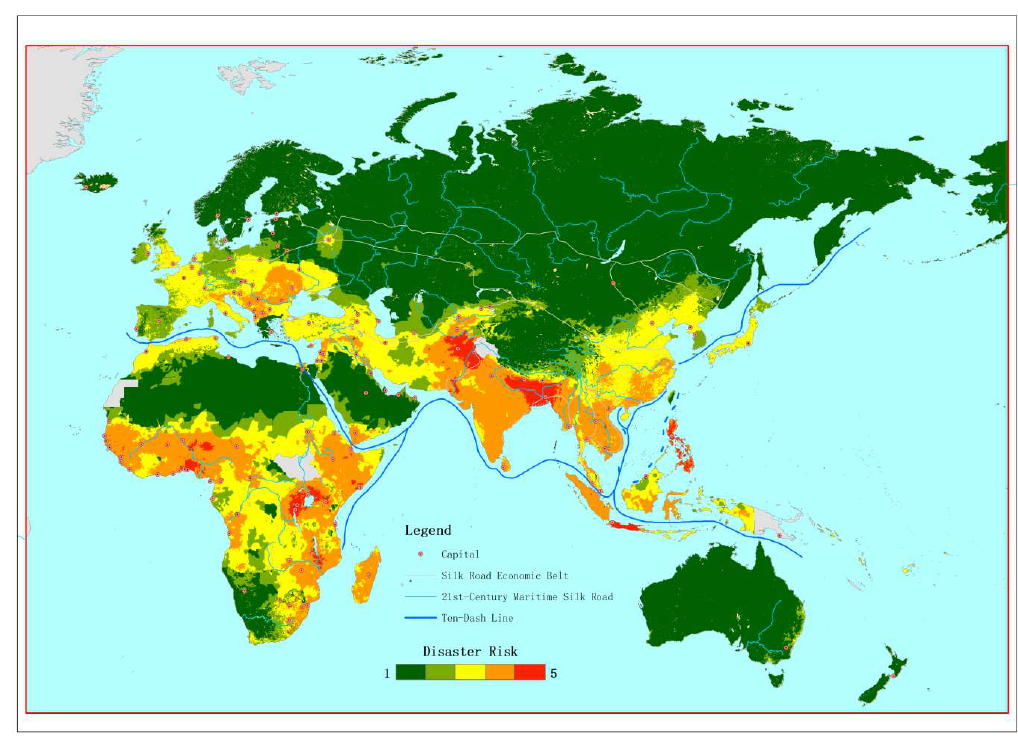
Figure 5. Health disaster risk of countries along the Belt and Road Initiative (BRI) region.